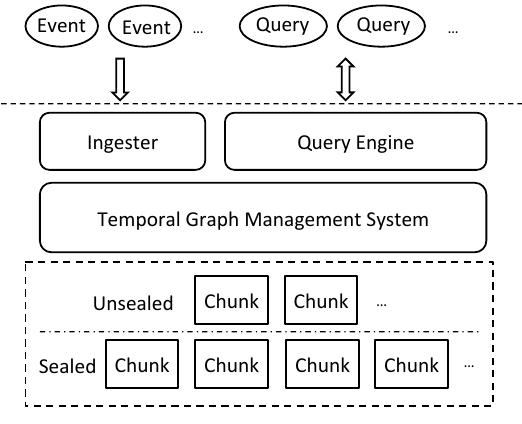
Fig. 2 Chunks tile to cover the entire temporal graph. Fig. 3 The overview of a temporal graph processing